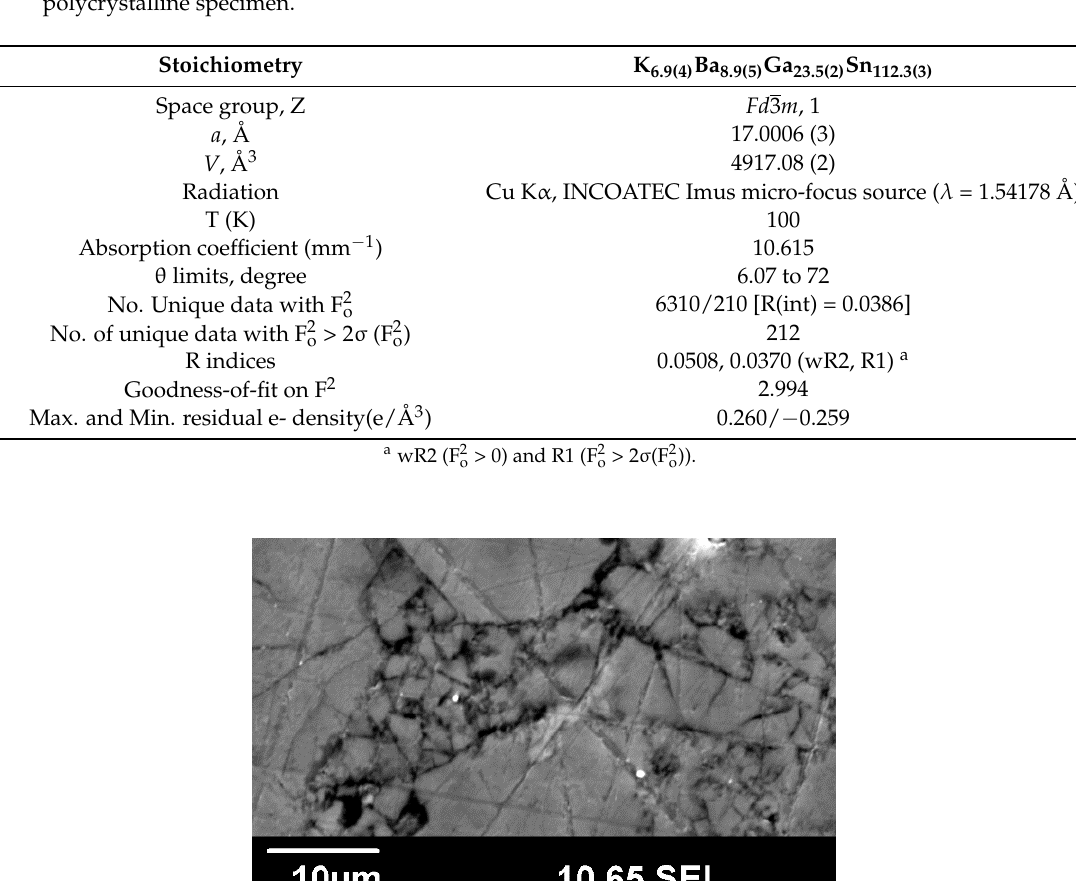
polycrystalline specimen.